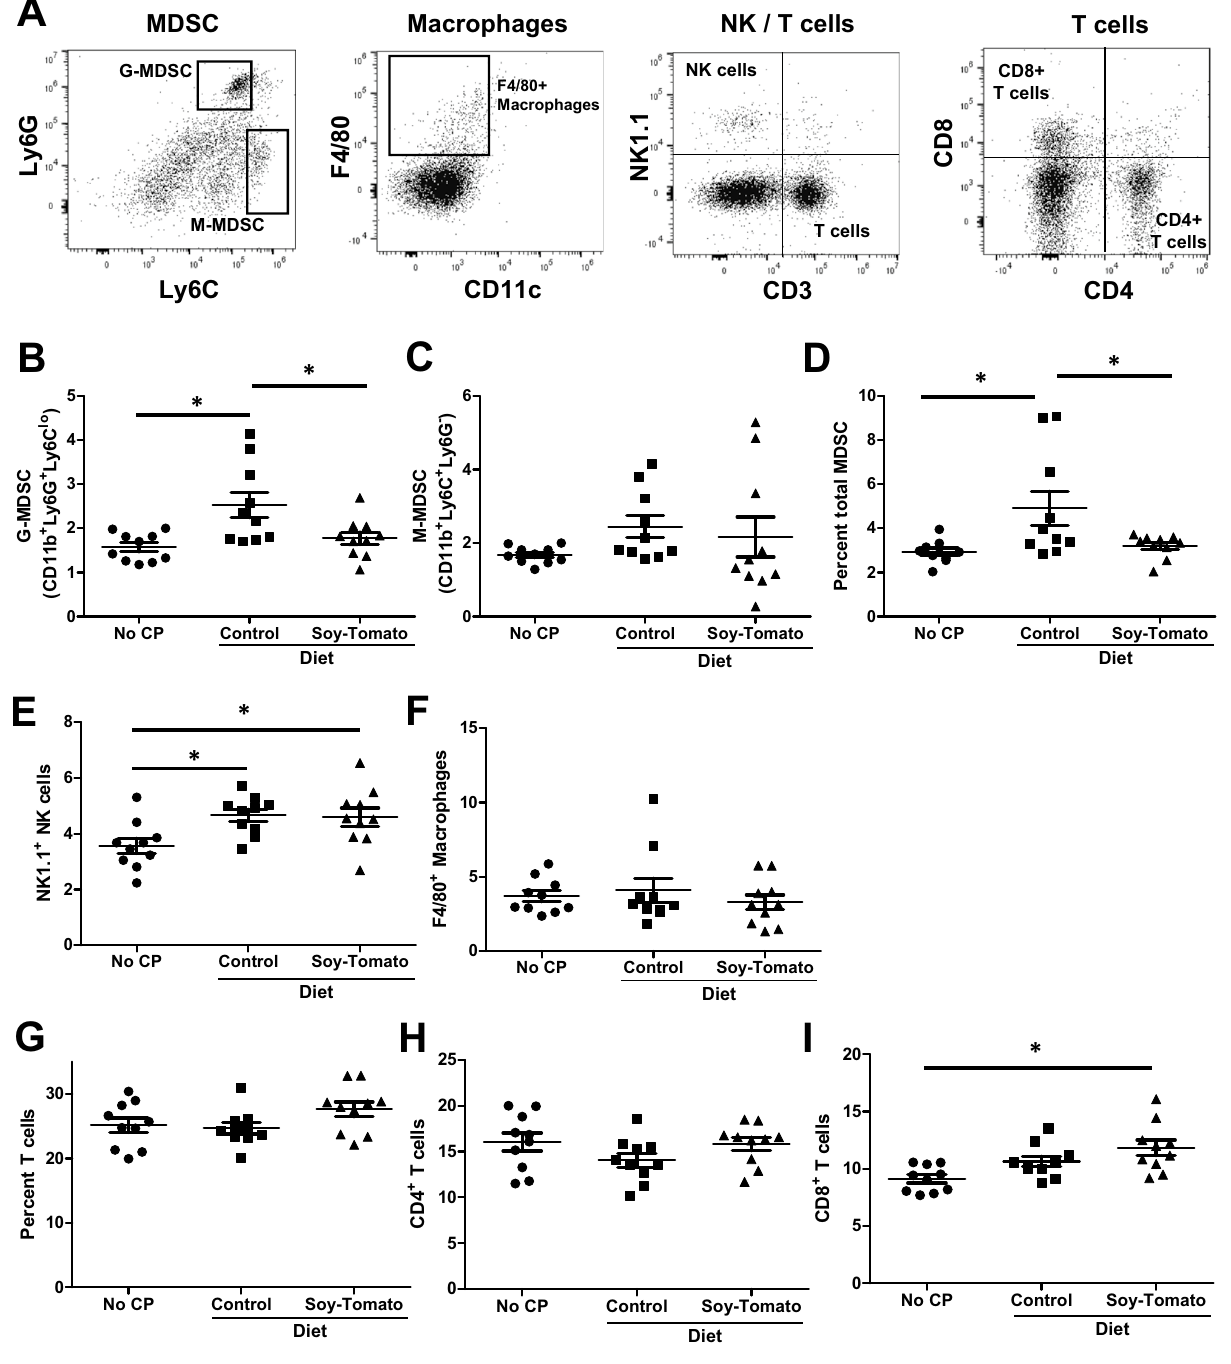
Figure 7. Soy-tomato diet modulates systemic immune populations in mice with CP. Splenocytes from healthy mice, mice with CP fed a control diet, or mice with CP fed a soy-tomato diet were stained by flow cytometry for circulating immune populations. ( A ) Representative plots illustrating gating strategy. Immune populations were quantified across the different cohort of mice identifying ( B ) CD11b + Ly6G + Ly6C lo granulocytic (g)-MDSC, ( C ) CD11b + Ly6C + Ly6G - monocytic (m)-MDSC, ( D ) total MDSC, ( E ) NK1.1 + NK cells, ( F ) F4/80 + macrophages, ( G ) total CD3 + T cells, ( H ) CD4 + T cells, and ( I ) CD8 + T